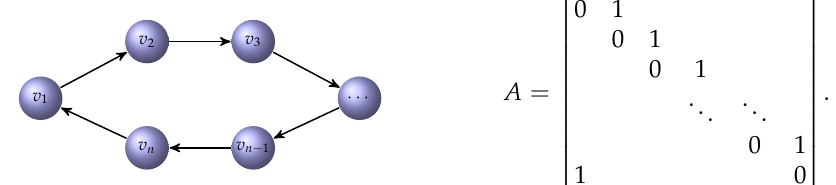
Figure 2. A directed circular graph G and its adjacency matrix A